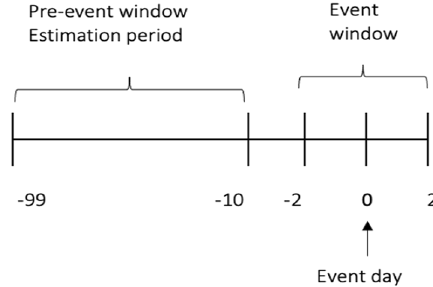
Fig. 6 Returns pre‑event and event window. Source : Created by